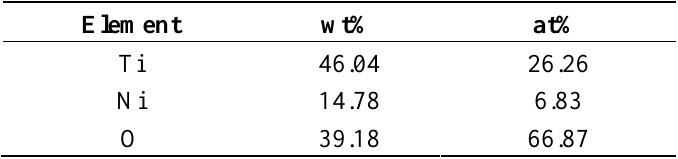
Table 1. Composition of the as-annealed Ti-Ni-O